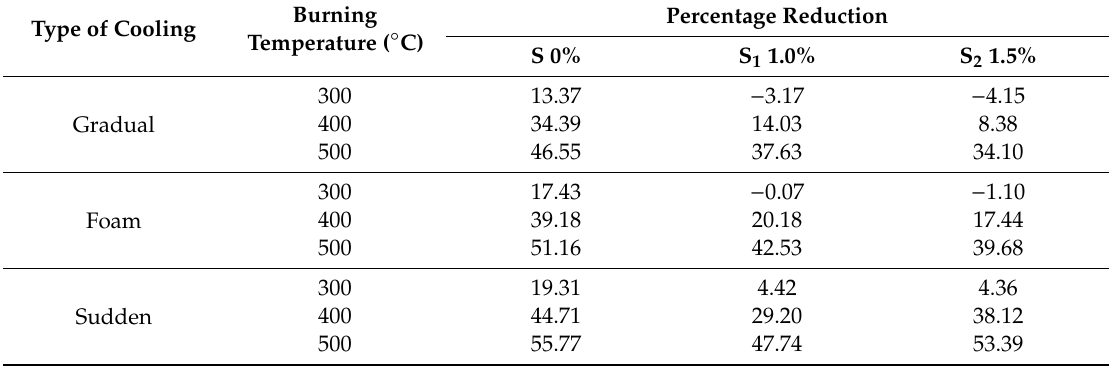
Figure 8. Splitting tensile strength concerning all burning temperatures and cooling methods: ( a ) For 0% V f ; ( b ) For 1.0% V f ; and ( c ) For 1.5% V f .